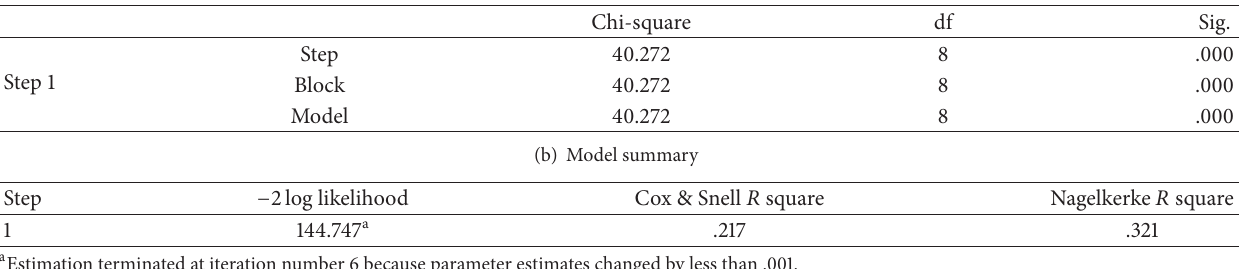
Table 3: Logistic regression model for the predictors of unfavourable outcome.